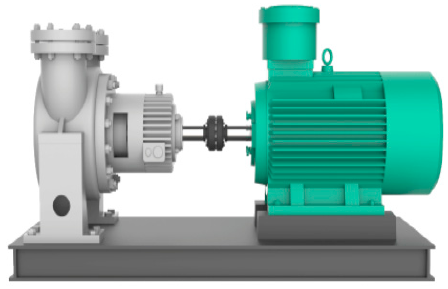
Figure 8. The monitored engineering object. Table 3. The collected vibration values of the monitored machine.